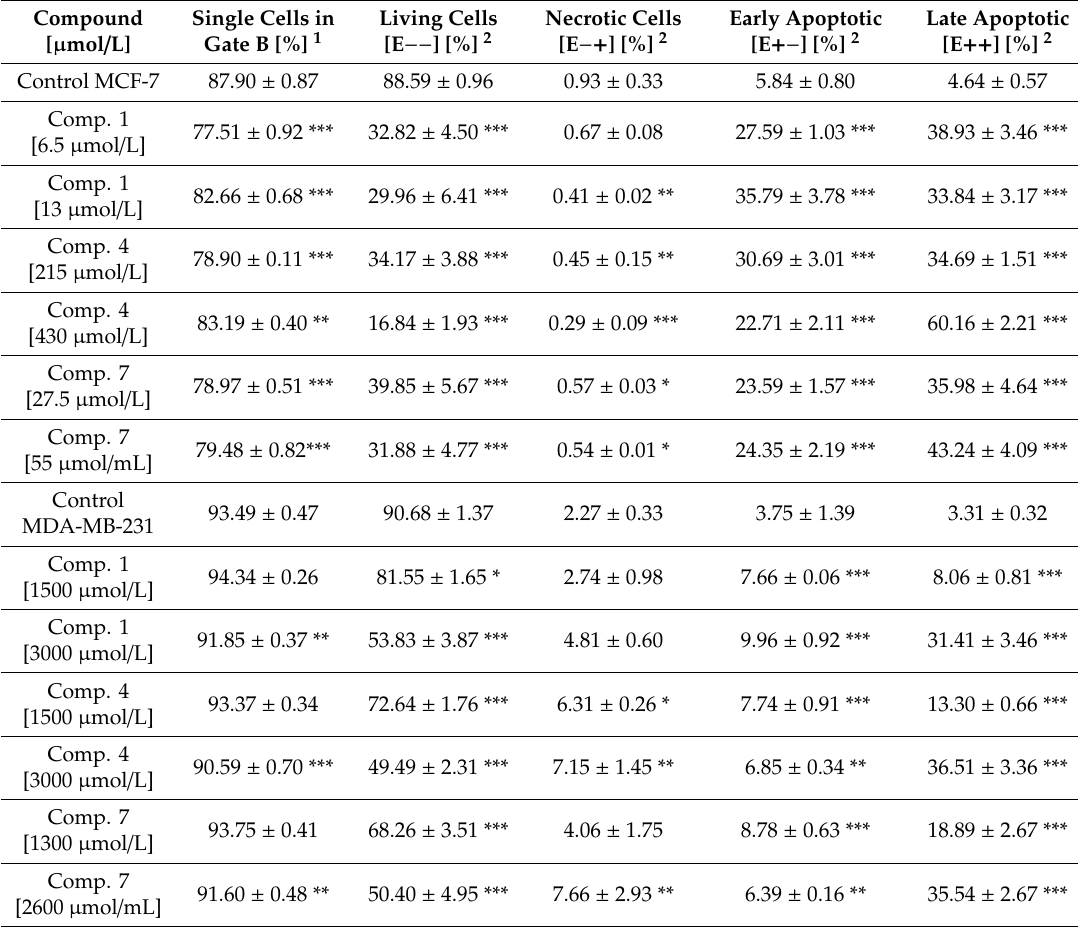
Table 4. Annexin V-FITC / PI double-staining analysis of apoptosis in MCF-7 and MDA-MB-231 cells.